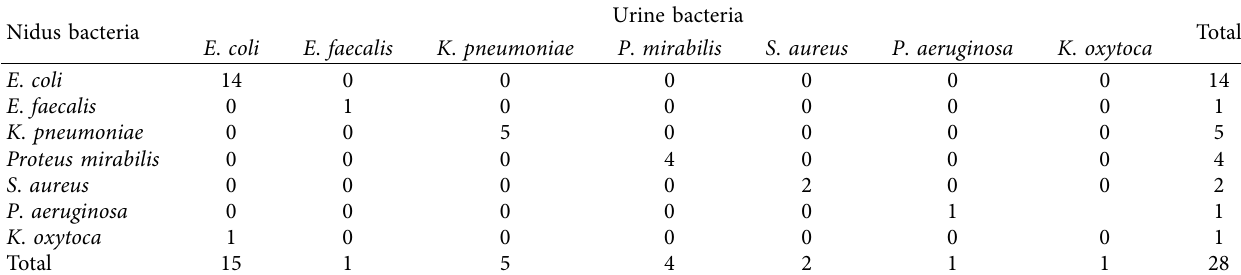
Table 3: Similarity in urine and stone matrices (nidus) culture.